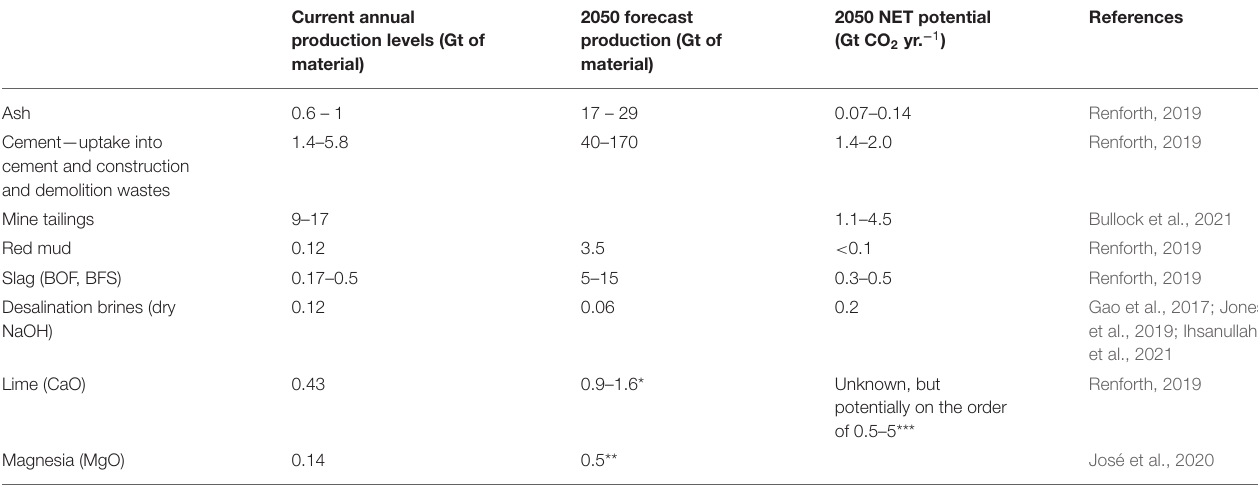
TABLE 2 | Current production values for some common artificial minerals used in geochemical NETs, with estimated production values and NET potentials by